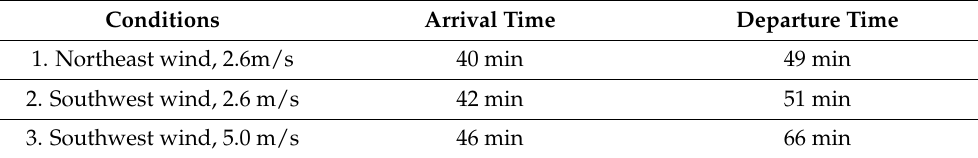
Table 2. The time of arrival and departure of the oil slick in different conditions.